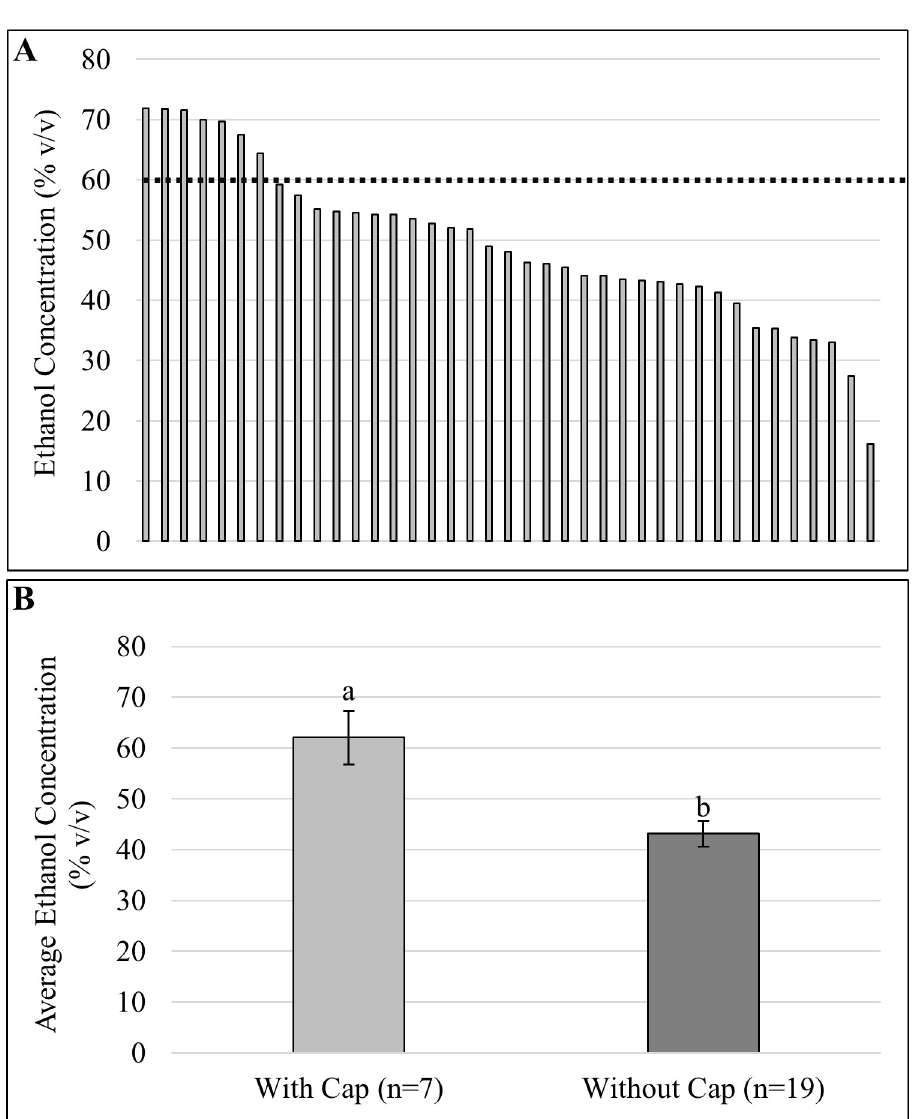
Fig 2. Ethanol concentration in ABHS samples sourced from single school district. Ethanol concentration of ABHS samples from single school district in South Carolina. Panel A: Distribution of ethanol concentrations (% v/v) measured from 39 individual dispensers. Black dashed line indicates 60% ethanol, the minimum concentration of ethanol required for the ABHS product to be compliant with FDA OTC Drug regulations [23]. Panel B: Average ethanol concentration is associated with status of refill cap placement. A total of 39 ABHS samples from a single school district was analyzed for ethanol concentration. Upon inspection of photos, many dispensers had refill caps removed (n = 19), some had caps installed (n = 7), and some were unable to determine based on photographs (n = 13). When grouped by status of cap placement, a significant difference in average ethanol concentrations (% v/v) was observed. Refill cap status (with or without) was significantly associated with rate of ethanol loss ( P < .05) based on one-way ANOVA with cap status as treatment and average ethanol concentration as independent variable. Letters above each bar graph indicate statistically different mean ethanol percentages using Tukey’s HSD post-hoc test for separation of means.